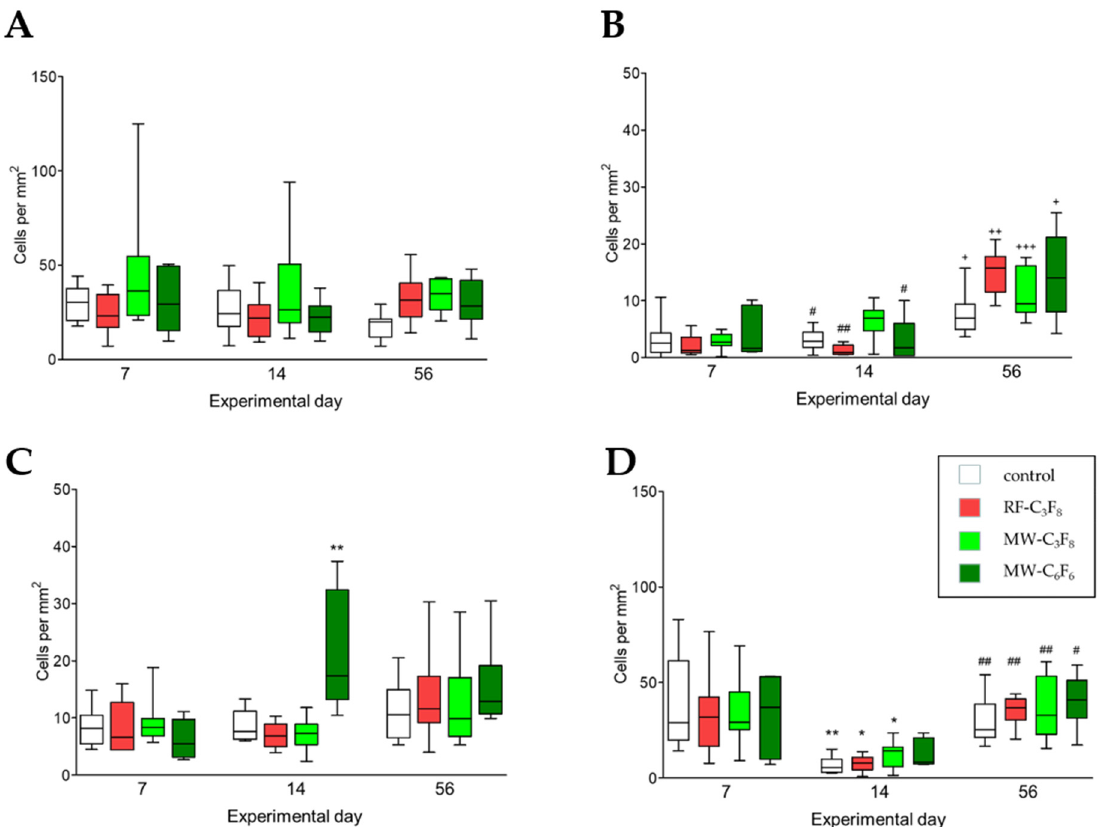
Figure 2. ( A – D ). Quantity of positively stained cells per mm 2 for ( A ) total T lymphocytes (R73), ( B ) IL-2R+ regulatory T lymphocytes (OX39), ( C ) mast cells (toluidine blue staining) and ( D ) activated NK cells (ANK61) in the peri-implant tissue surrounding uncoated Ti6AI4V plates (white bars) and Ti6AI4V plates coated with the anti-adhesive plasma-fluorocarbon-polymers RF-C 3 F 8 (red bars), MW-C 3 F 8 (light green bars) and MW-C 6 F 6 (dark green bars) at days 7, 14 and 56 after simultaneous intramuscular implantation in rats. Boxes represent the median and interquartile range of eight rats per experimental day; p -values represent significant differences between experimental days. * p < 0.05, ** p < 0.01 (day 7 vs. day 14), + p < 0.05, ++ p <0.01, +++ p < 0.001 (day 7 vs. day 56), # p < 0.05, ## p < 0.01 (day 14 vs. day 56), Kruskal–Wallis test with Dunn’s post hoc test.